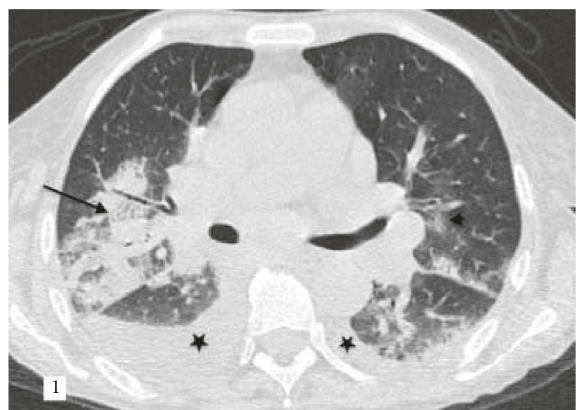
Figure 1: A 70-year-old female patient diagnosed with HCoV-OC43 pneumonia and chronic lymphocytic leukemia (CLL). According to the RSNA guidelines, CORADS score is given as 5. GGO (crazy paving) (black arrow) accompanied by interlobular and intralobular septal thickening on the axial CT section and patchy consolidation areas, faint GGO areas (black arrowhead), and pleural effusion (asterisks).